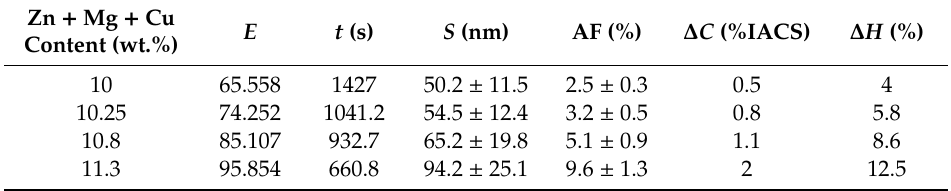
Table 5. Lattice distortion energy of solid solution, quenching phase and quench